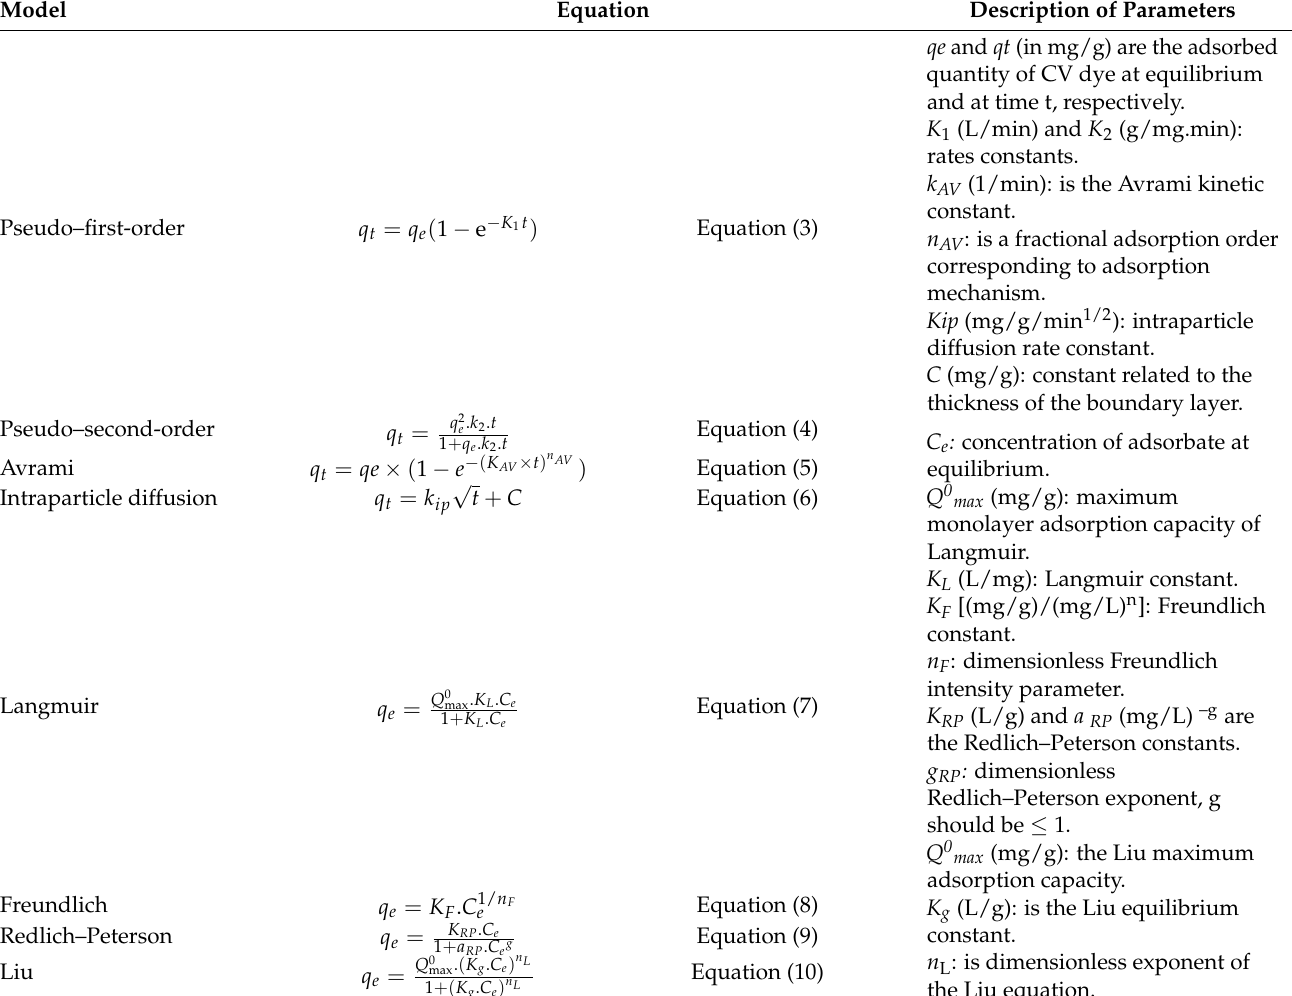
Table 2. Equations, relevant parameters, and references of the applied kinetic and isotherm models. Model Equation Description of